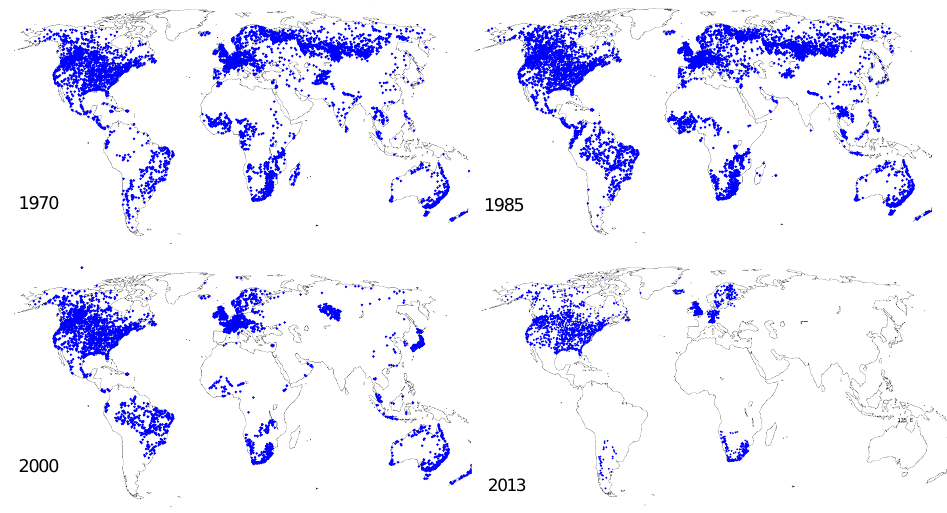
Figure 1. Available stations (updated in March 2017) with discharge data according to the Global Runoff Data Centre (GRDC) database (http://www.bafg.de/GRDC) for different years from